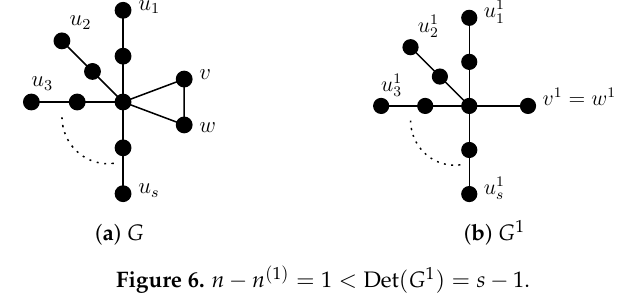
Figure 6. n − n ( 1 ) = 1 < Det ( G 1 ) = s − 1.